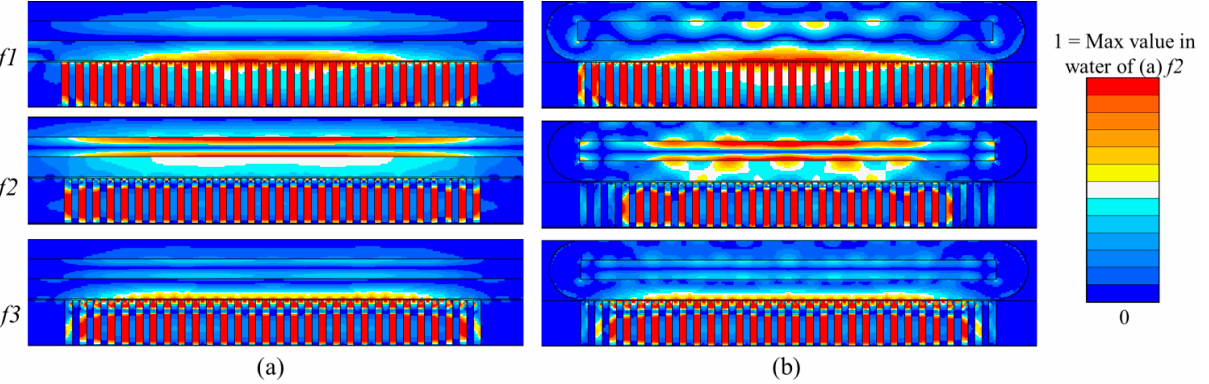
Figure 10. Pressure fields of ( a ) all 30 array elements ( xz -plane); and ( b ) 30 PMN-PT pillars ( yz -plane) driven at the peak response